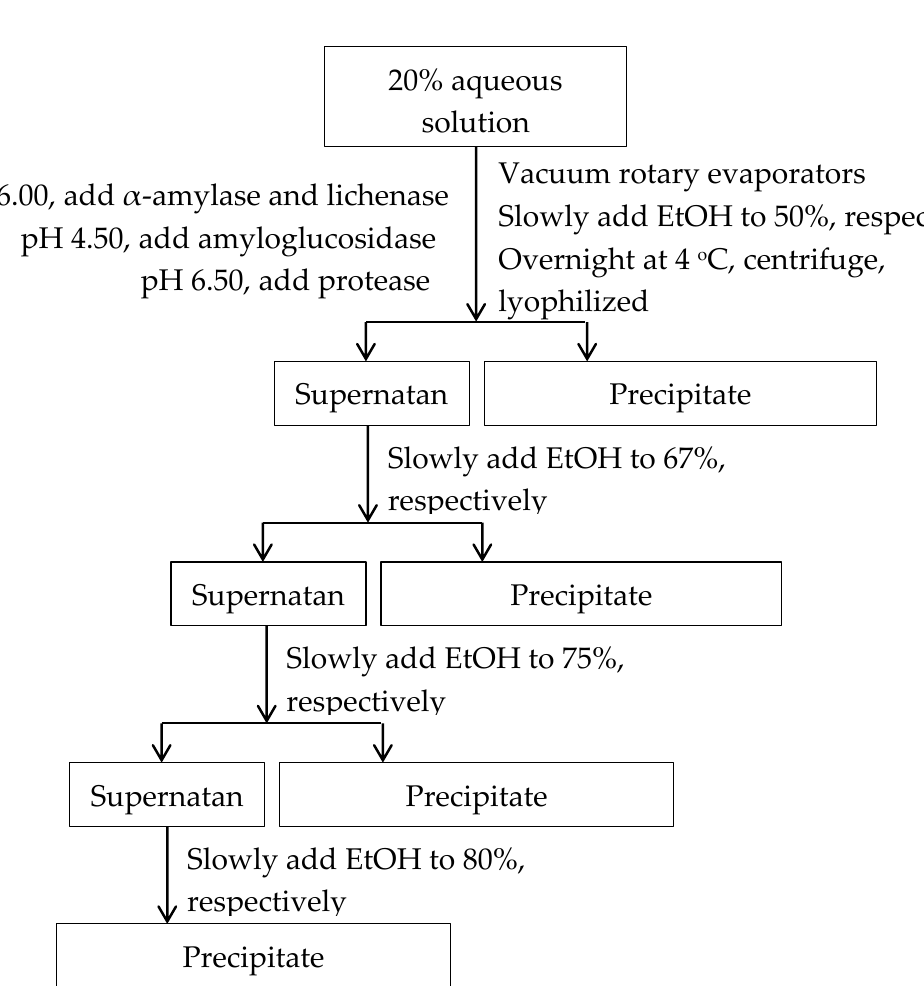
Figure 3. Procedure for arabinoxylan fraction by gradient ethanol precipitation. 287